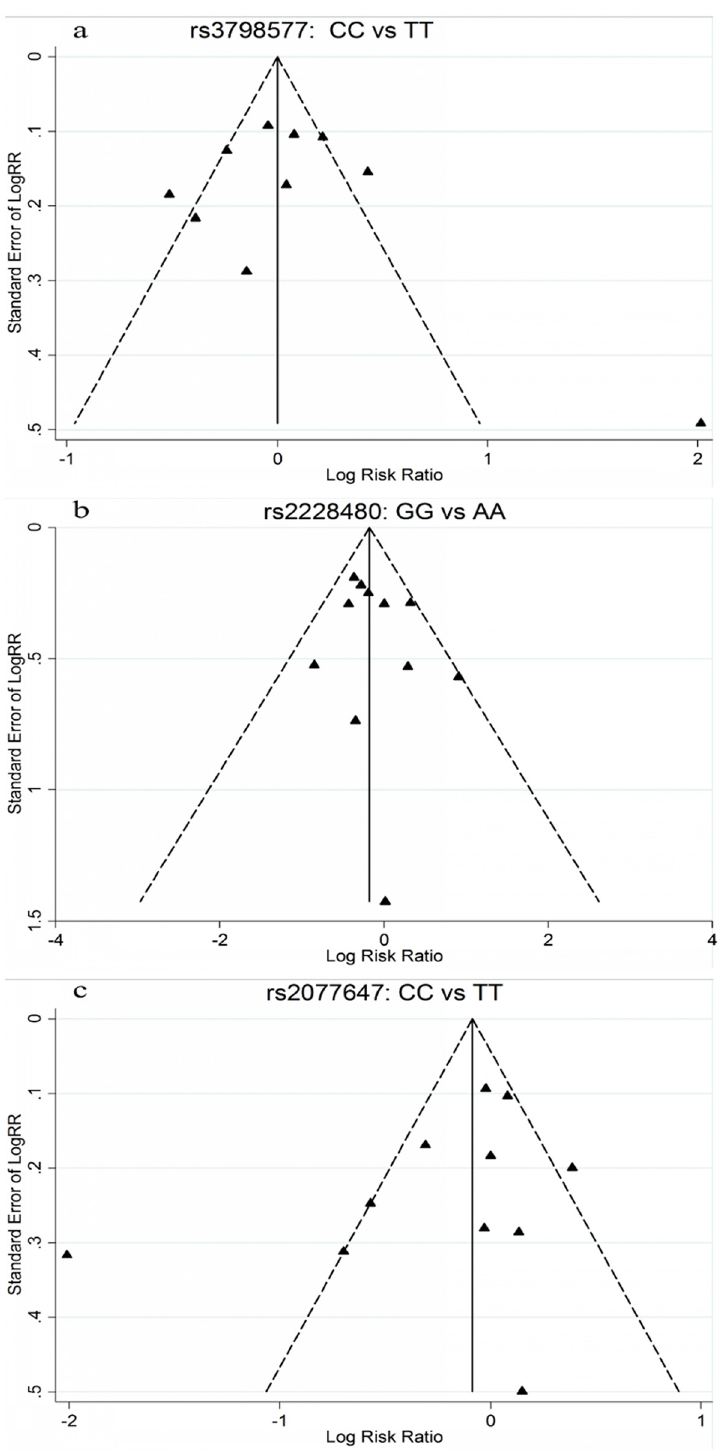
Fig 5. Funnel plot analysis to detect publication bias in the variant homozygote versus wild-type homozygote model. a Funnel plot analysis of rs3798577; b Funnel plot analysis of rs2228480; c Funnel plot analysis of